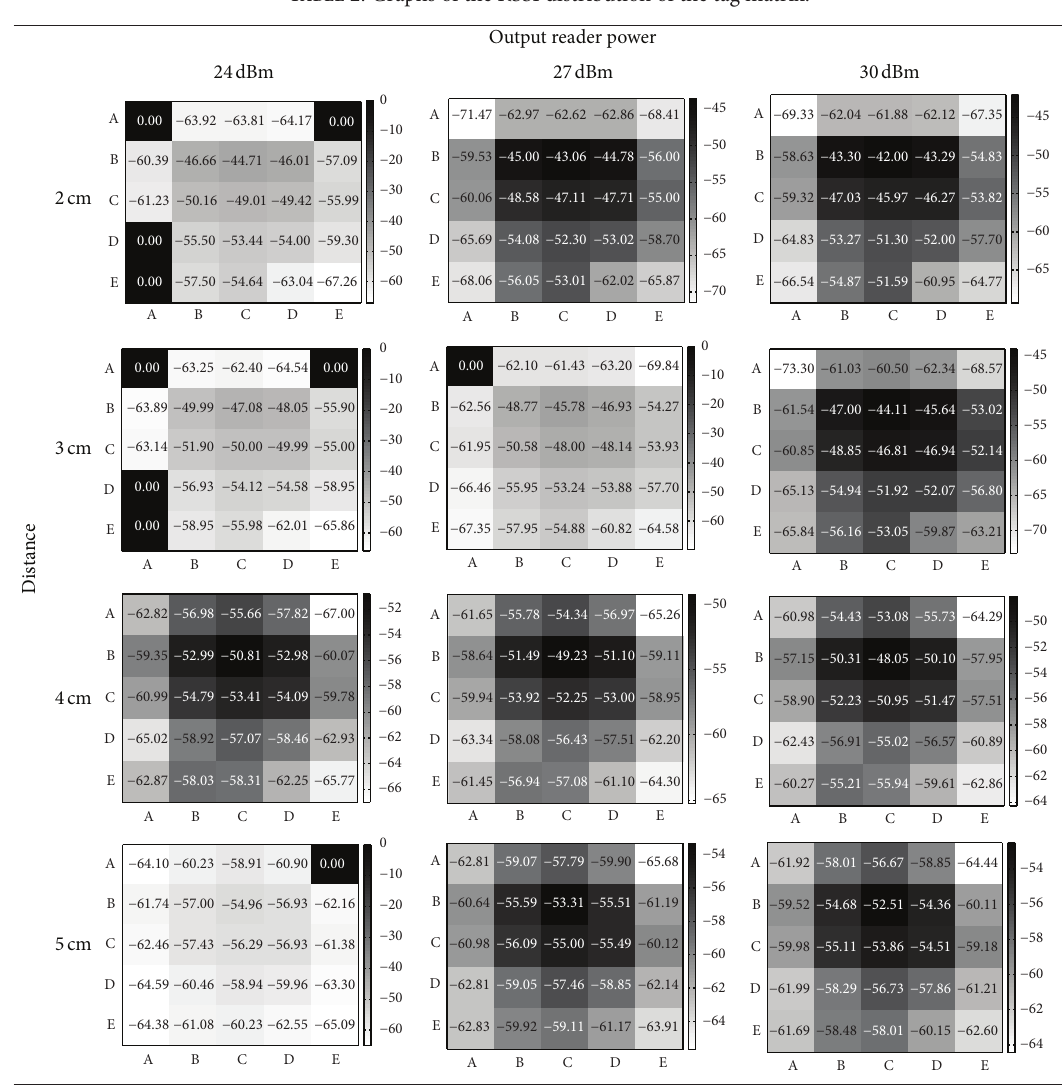
Table 2: Graphs of the RSSI distribution of the tag